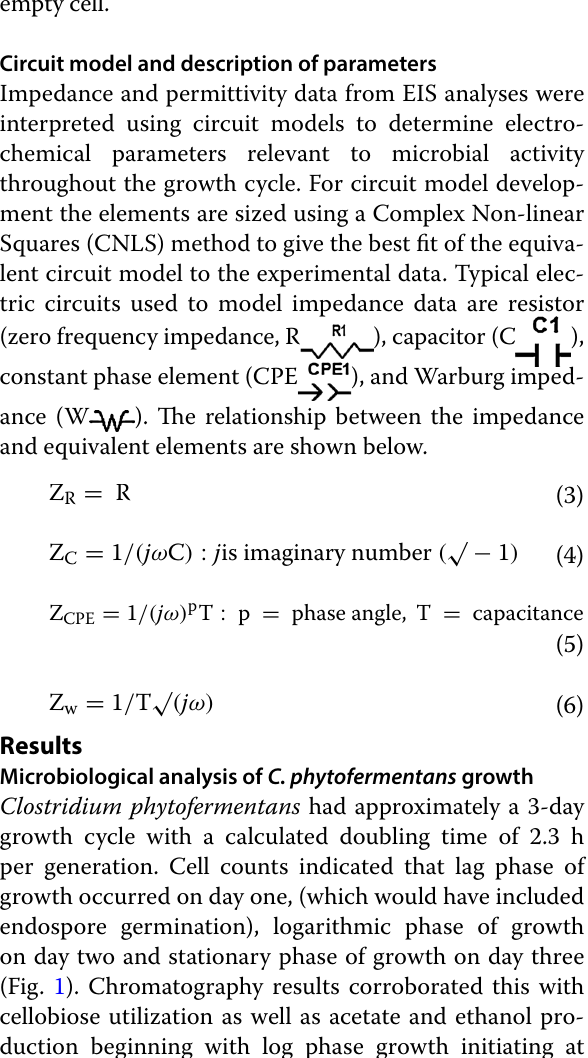
Fig. 2 Cell density correlated with reduction peak charge density. Variations in charge density of the reduction peaks generally followed growth data from mid-log phase growth until stationary